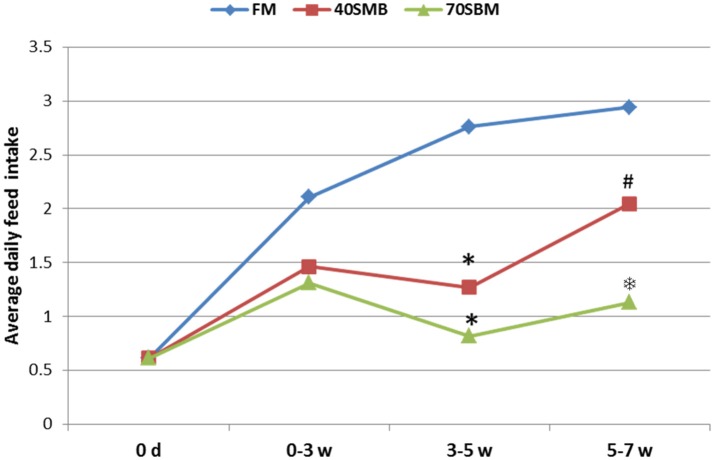
Average daily food intake (ADFI) of grass carp for different stages, including early (0–3 week), middle (3–5 week), and late (5–7 week) stages, in FM, 40SBM and 70SBM groups. The stars (*) represent the significant decreases while the hash (#) represents the significant increases in the food intakes compared to the previous stage for each group. The factor that ADFI in the 70SBM group was much lower than the 40SBM group was indicated by the snowflake ().